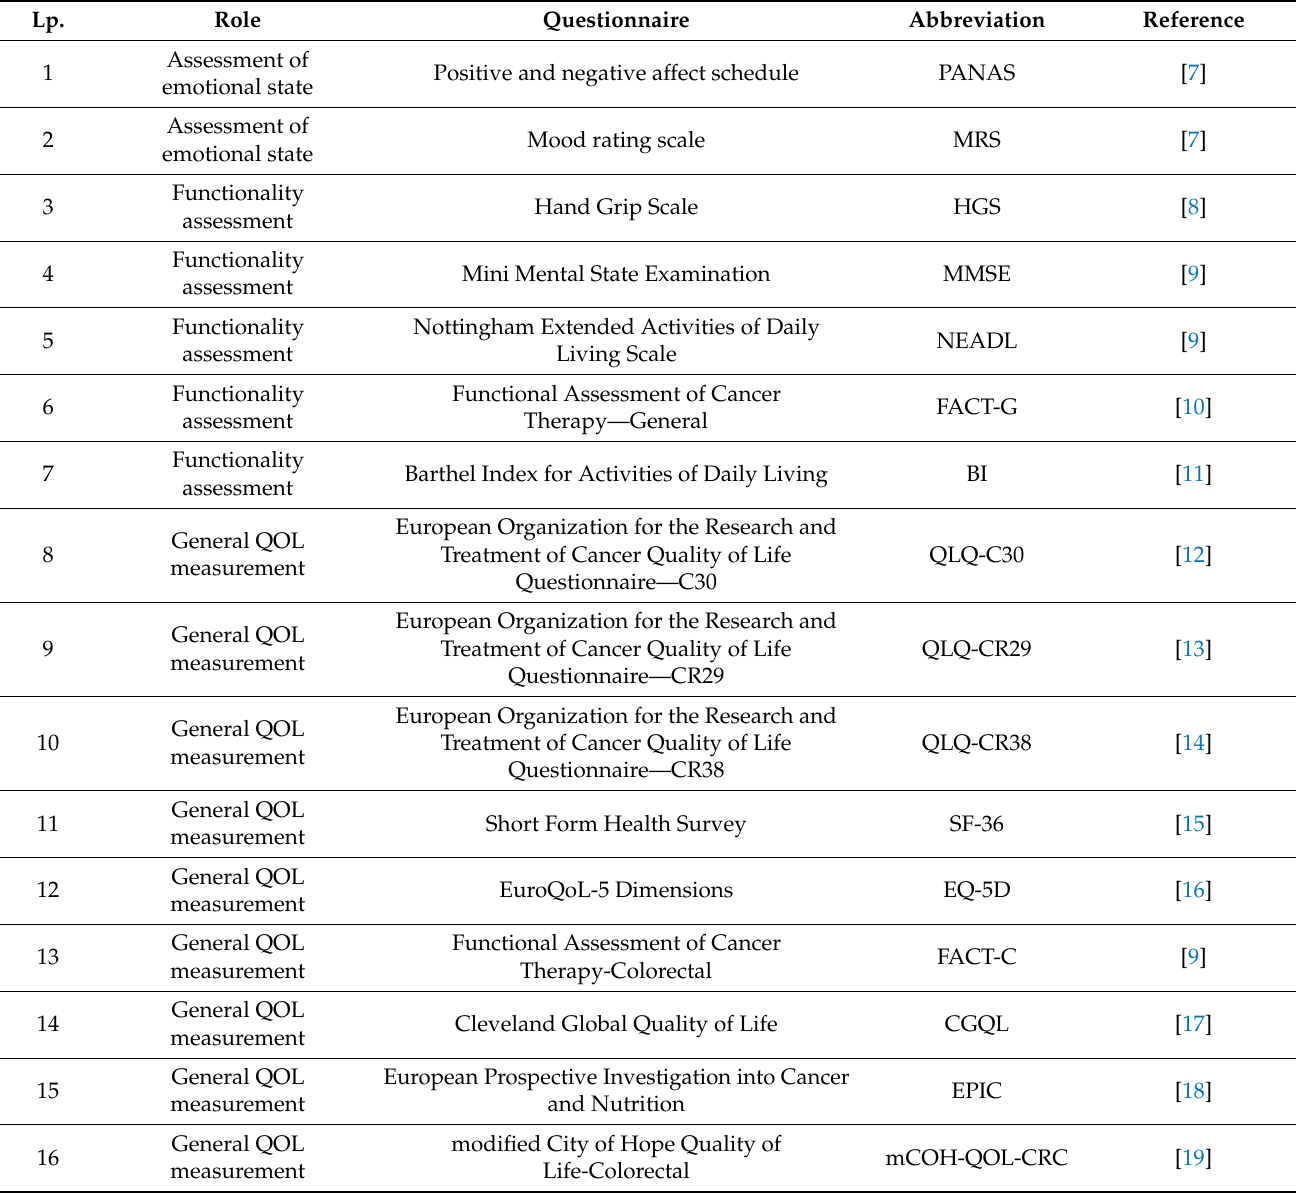
Table 1. Selected questionnaires for quality of life assessments of patients with colorectal